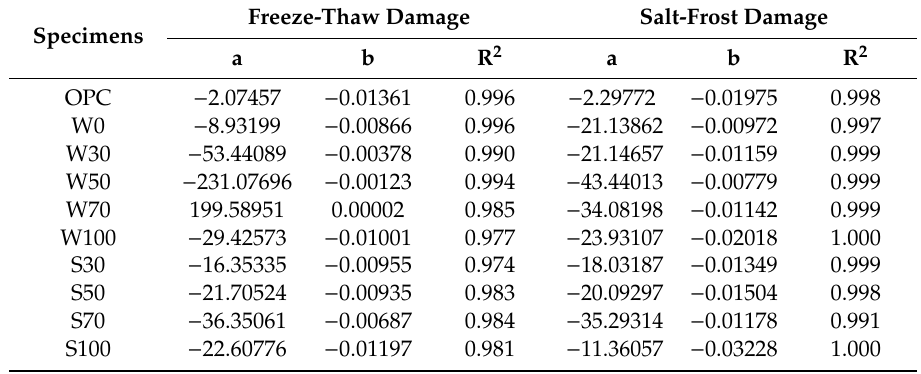
Table 5. Accumulative salt and water freezing damage exponential function parameters of ACSC.